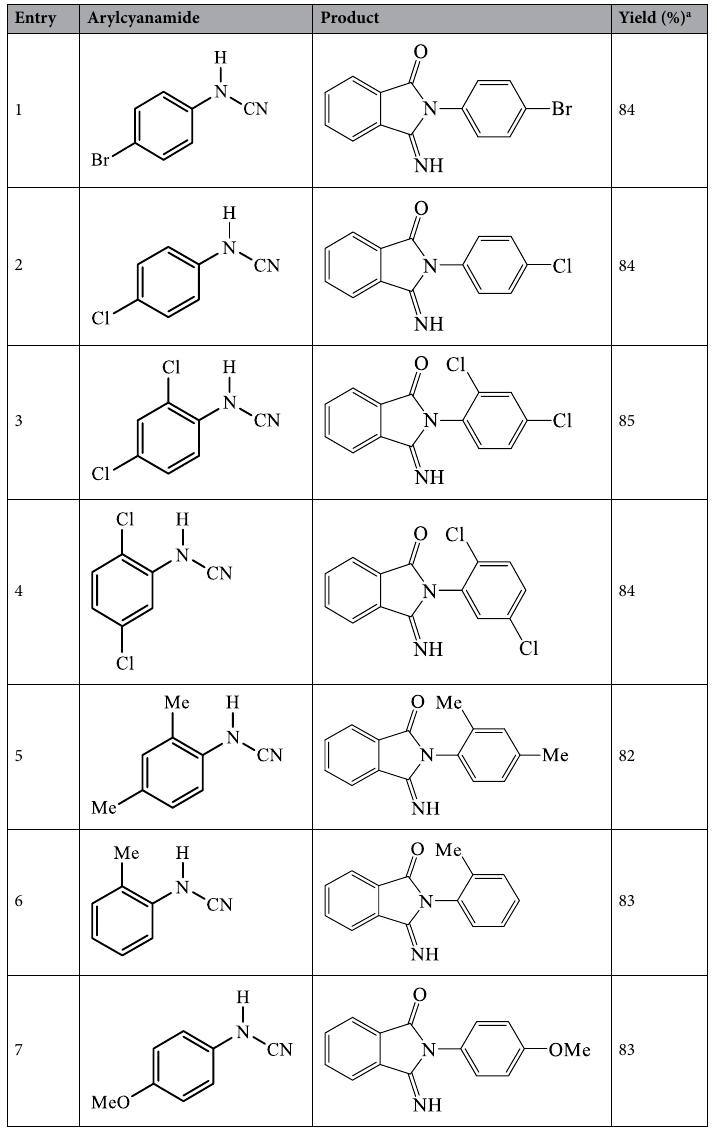
Table 2. Synthesis of 3-imino-2-phenylisoindolin-1-one derivatives using various arylcyanamides in EtOH. Reaction conditions: Benzoyl chloride (1 mmol), arylcyanamide (1 mmol), catalyst (1.93 mol% Cu content), EtOH (10 mL), room temperature, US irradiation, 5 h. a Isolated